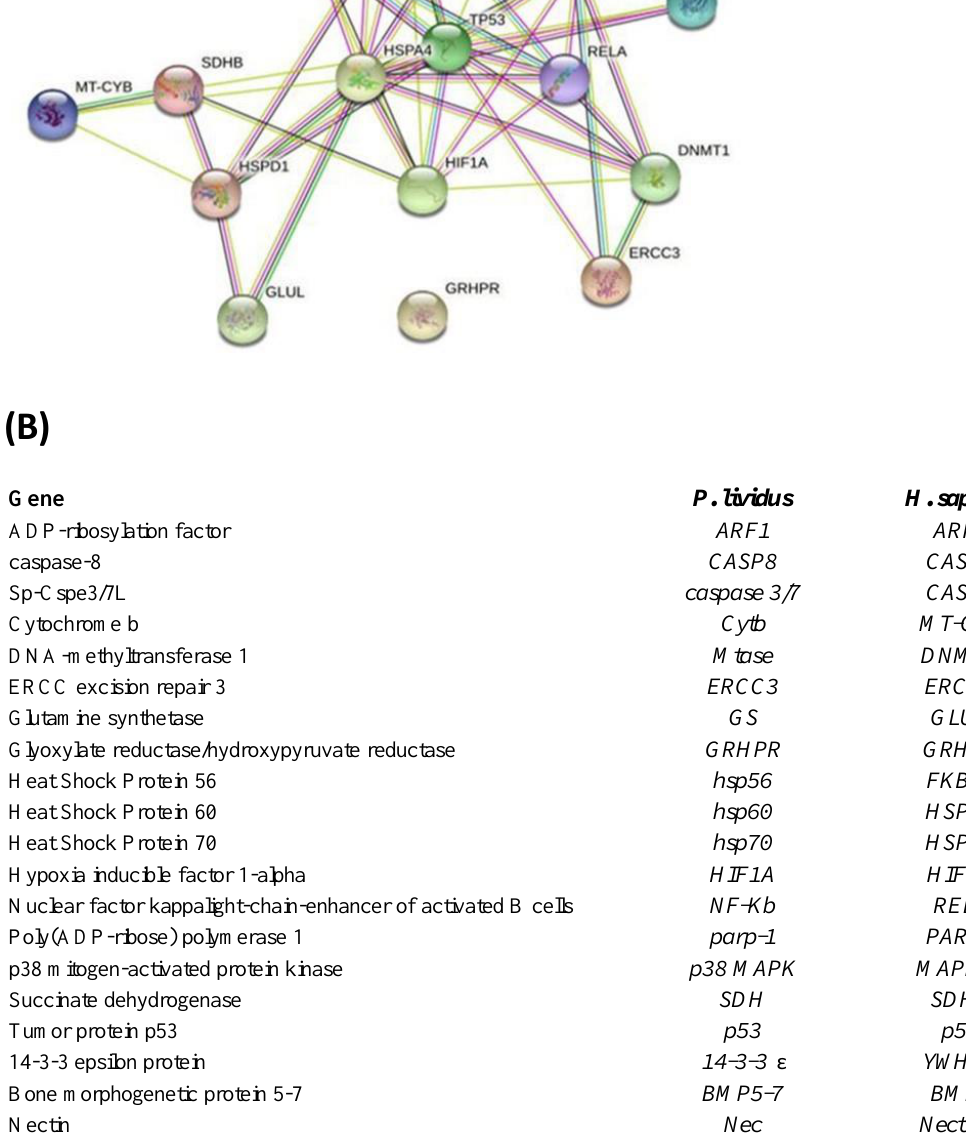
Figure 3. ( A ) Interactomic analysis by STRING (https://string–db.org/; accessed on 30 April 2022). The network graphically displays the relationship between genes. The biological relationships between genes are indicated by different colors. Known interactions: reported by database = light blue and determined experimentally = pink. Expected interactions: gene proximity = green; gene fusion = red; and genes with similar pattern = light blue. ( B ) Homo sapiens gene names and the corresponding P. lividus orthologous genes. The most significant relations among genes (confidence score cut-off = 900) displaying experimental evidence are highlighted.